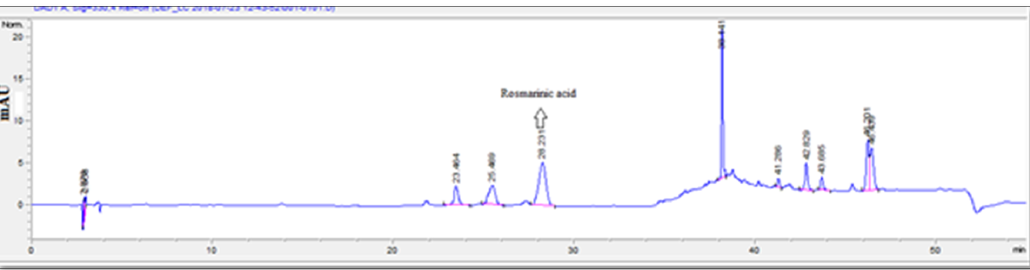
Figure 5. Chromatogram of released extract from liposome formulation.